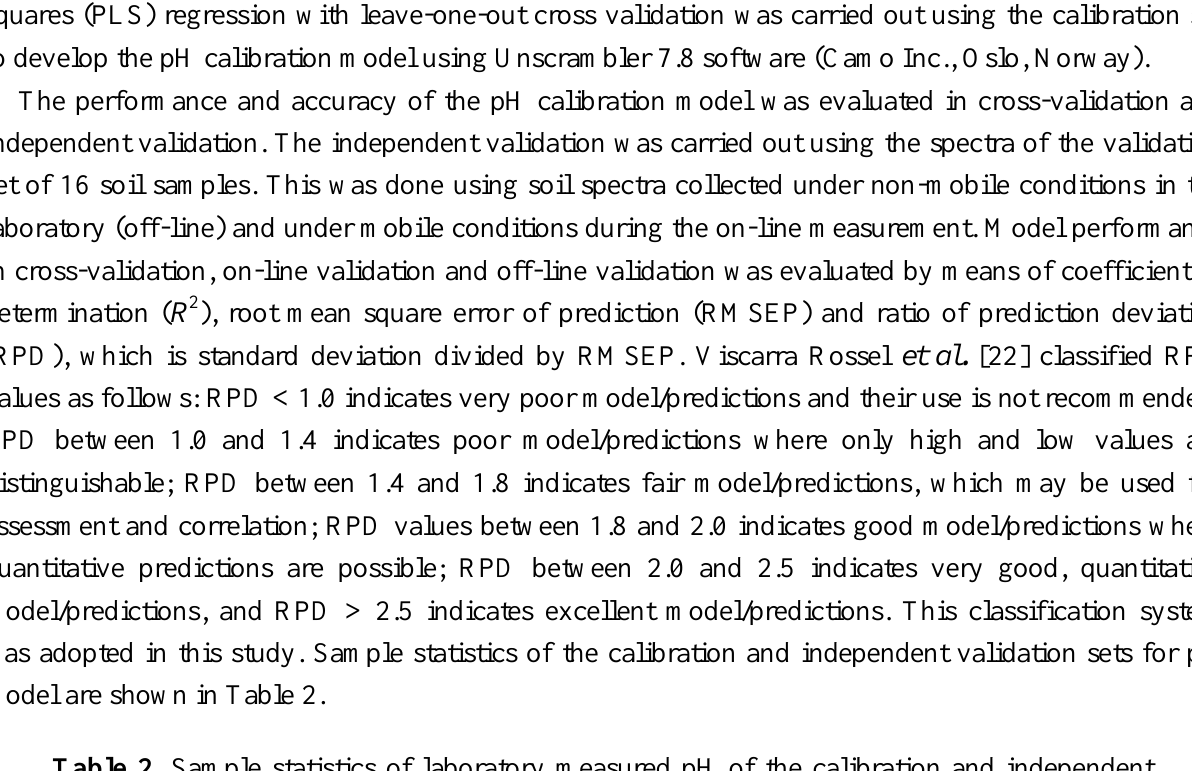
Table 2. Sample statistics of laboratory measured pH of the calibration and independent validation